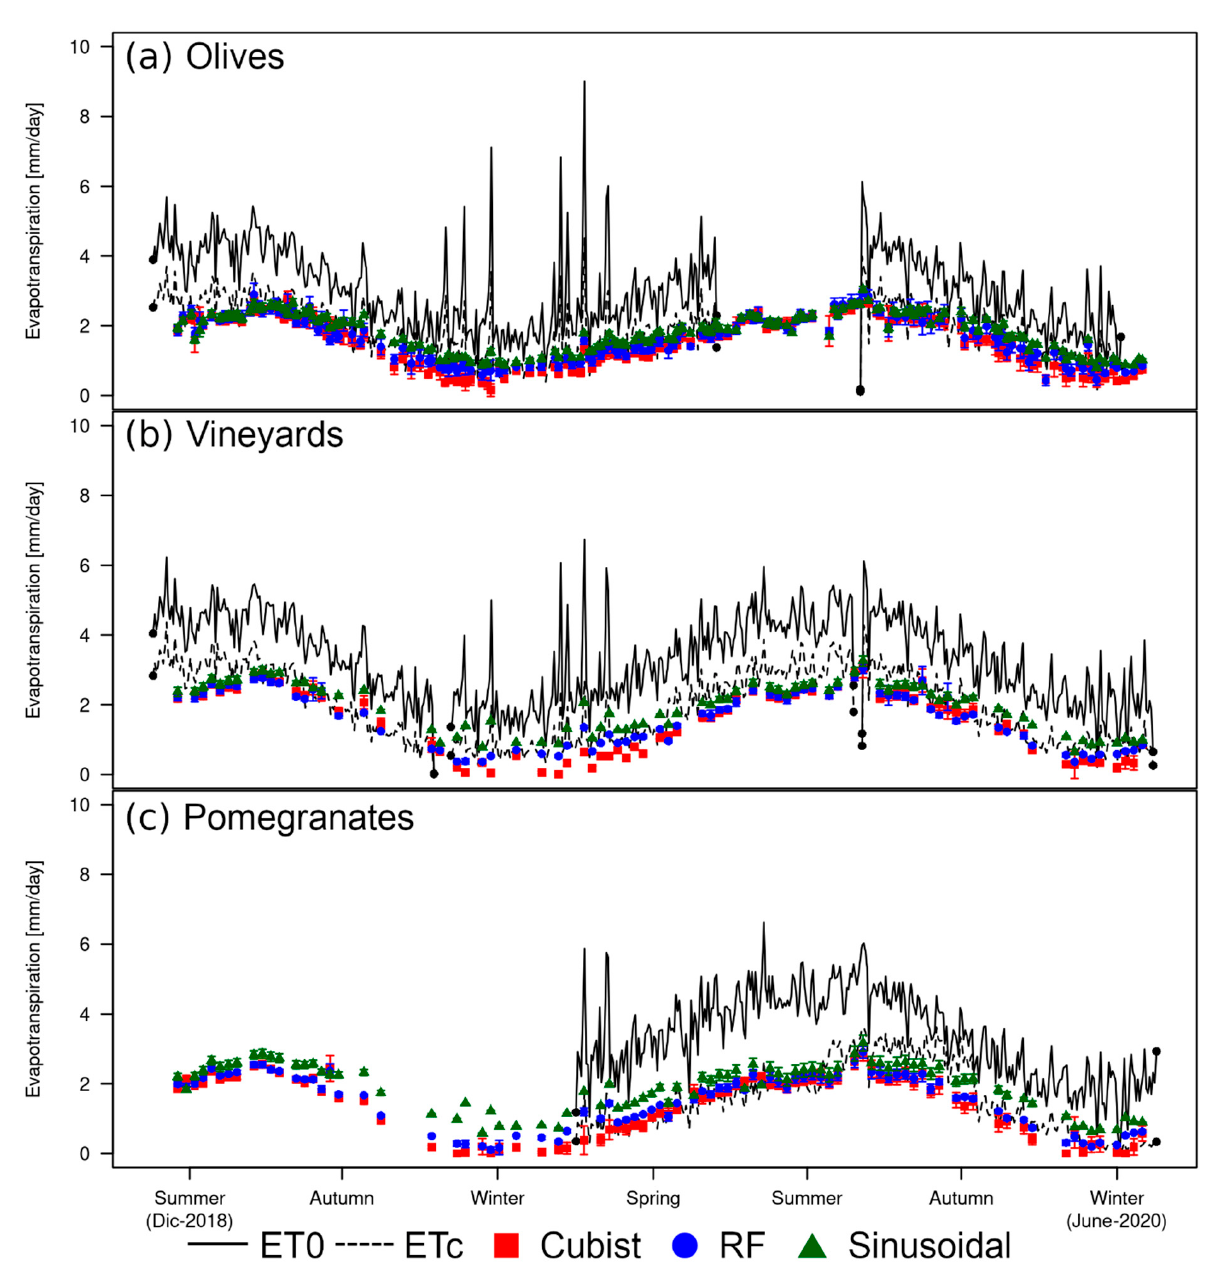
Figure 8. Temporal series of the predicted ETa at 100 m with cubist, random forest, and sinusoidal models versus the ETa measured by the in situ stations at ( a ) olives, ( b ) vineyards, and ( c ) pomegranates orchards. The error bars are showing the standard deviation of the 9 pixel cells surrounding the ETc station of each ETa model.